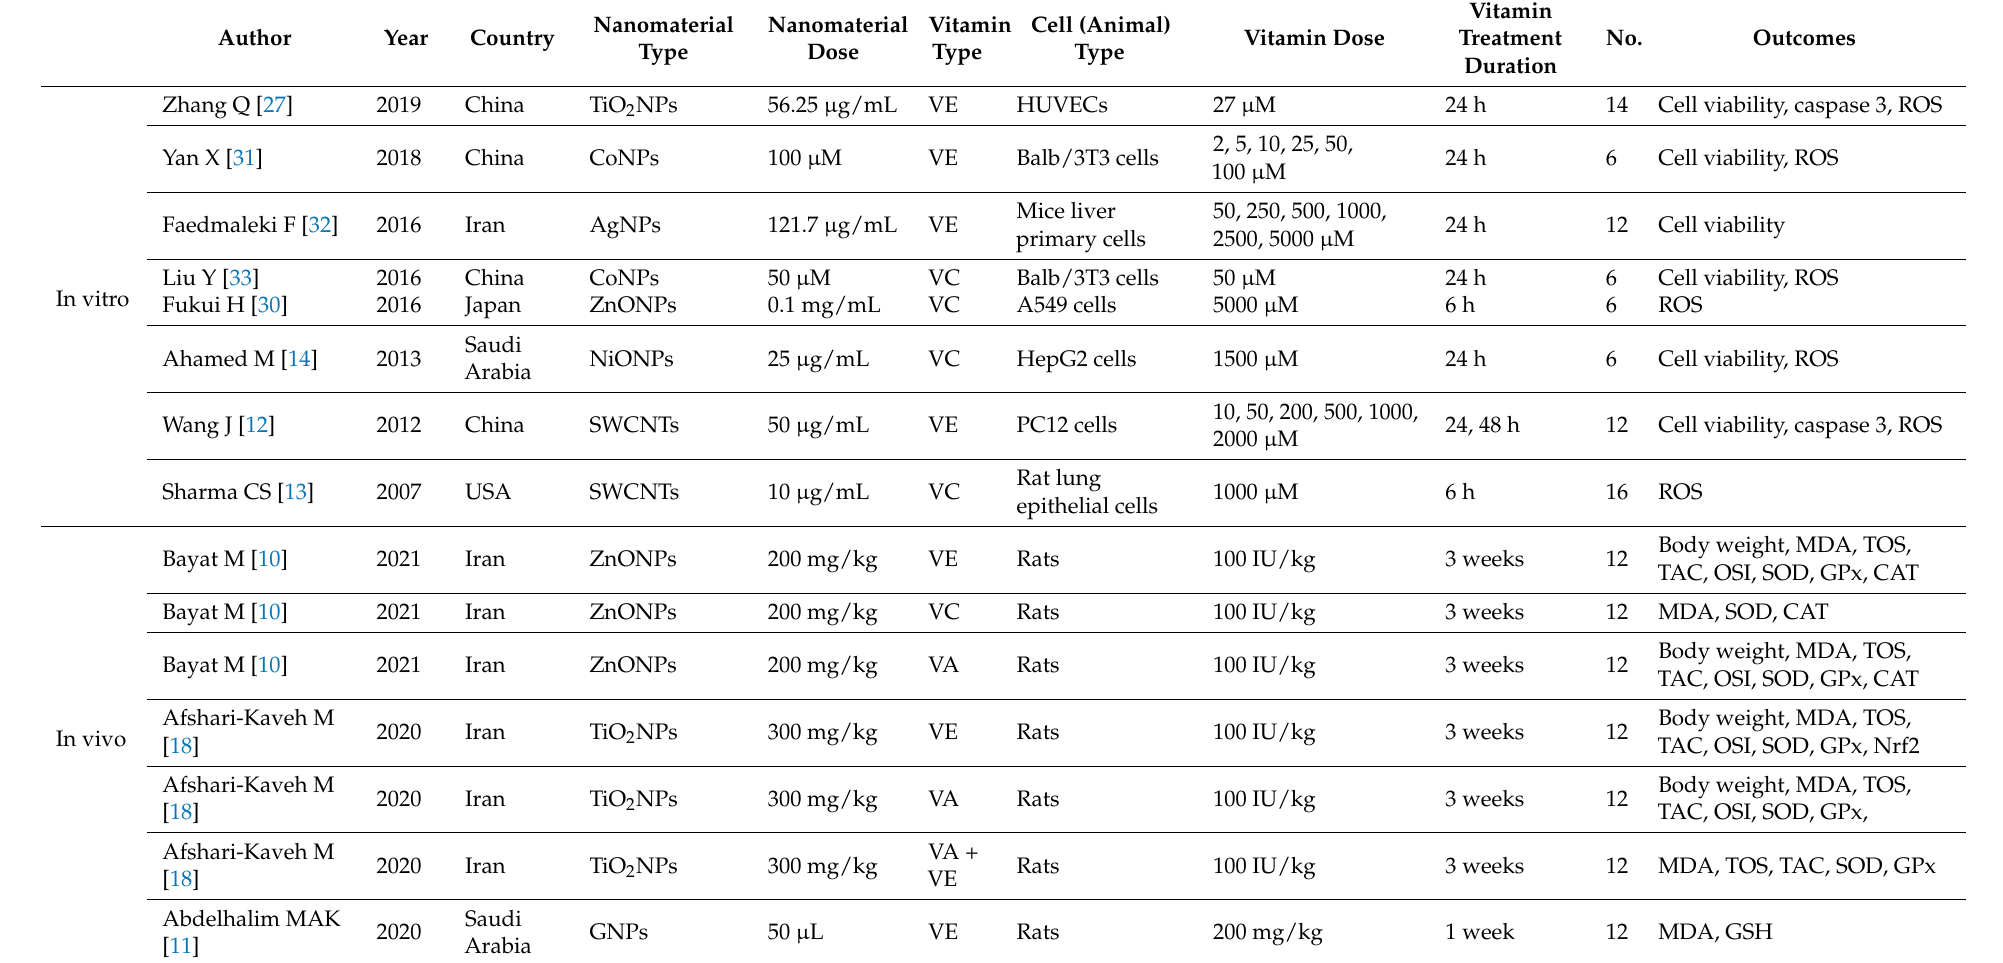
Table 1. Basic characteristics of included